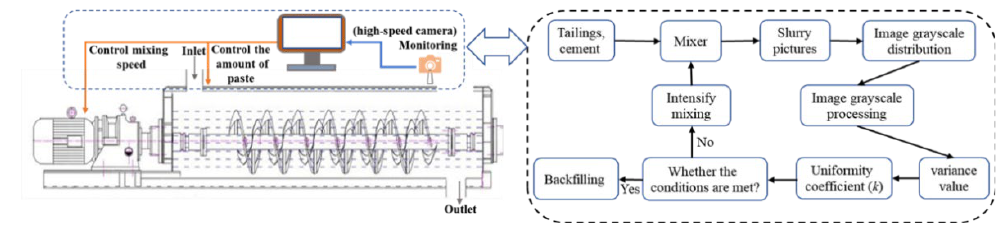
Figure 11. On-line monitoring of CPB undergoing